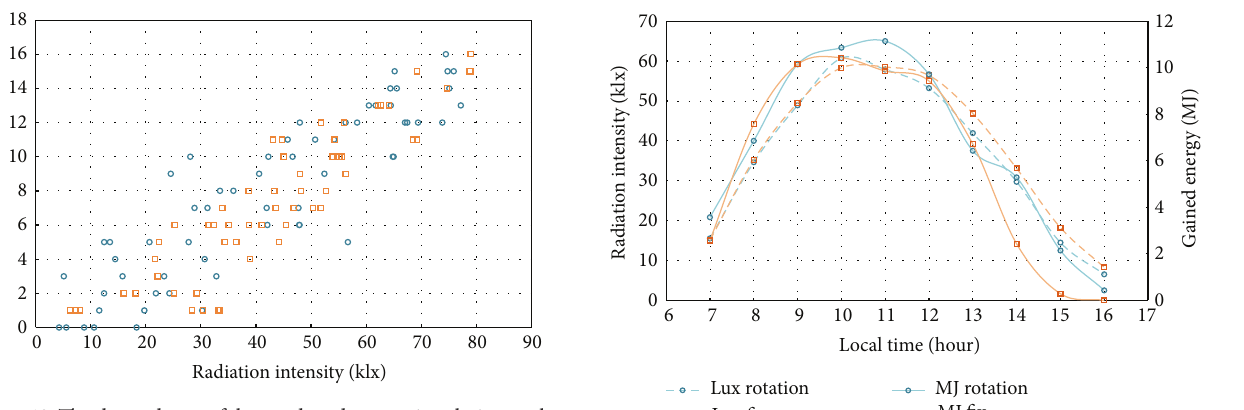
Figure 18: The dependence of the produced energy in relation to the radiation intensity.